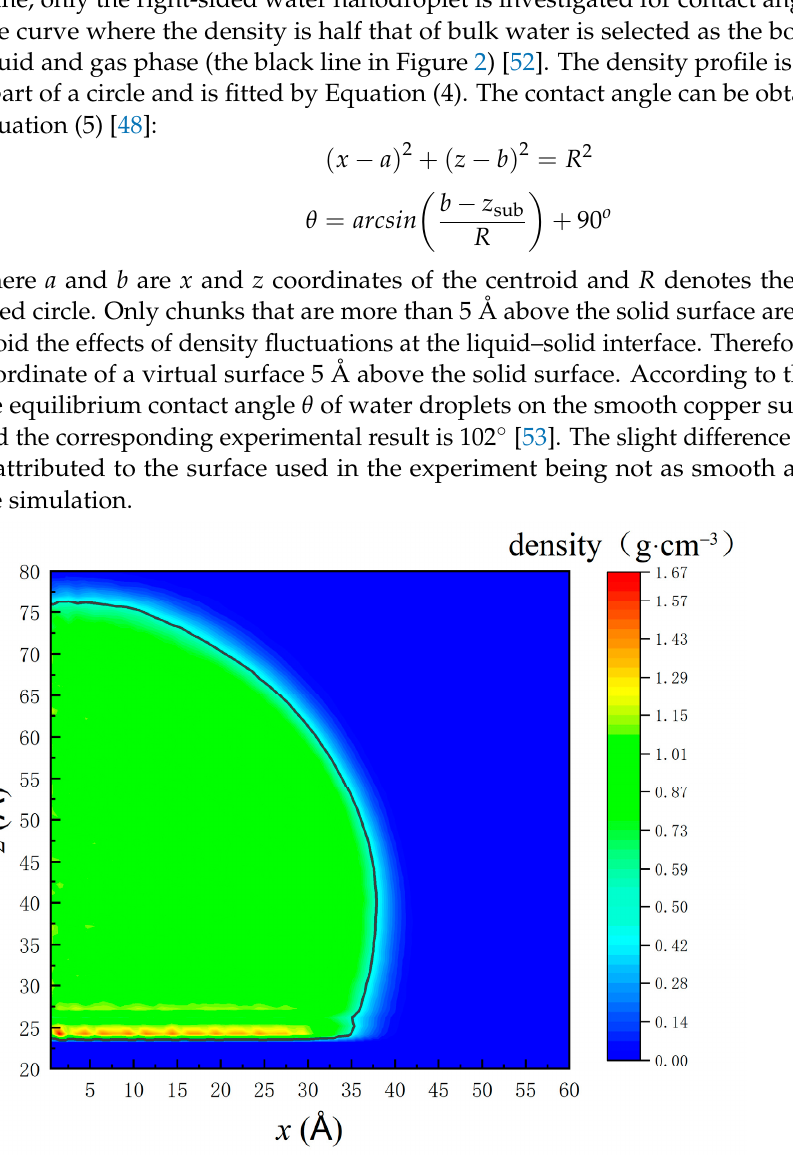
Figure 3. Effects of droplets size on spreading time. It can be seen that although the number of water molecules varies, the R / R 0 of differ- ent nanodroplets are similar to each other, and the maximum relative error is 6.9%. There- fore, the effect of the number of molecules arranged in the droplet can be neglected. Tak- ing the computation accuracy and efficiency into consideration, nanodroplets with R 0 = 35 Å are adopted. 3.2. Effects of Translation Velocity When Water Nanodroplets Impinge on Translation Surfaces Considering the inertia force plays an important role in the impinging process, the Weber number ( We ) is chosen to represent the characteristics of water nanodroplets [54]. The effects of translation velocity of surfaces V s on the dynamical behaviors of water nanodroplets with We = 7.41 are investigated. We is defined as 𝑊𝑒 = 𝜌𝑅𝑉 (cid:3053)(cid:2870) 𝛾 (6) where R is the radius of the droplet, V z represents the velocity of droplets, and the surface tension γ = 72.75 mN/m [52]. The morphological evolution of water nanodroplets is illus- trated in Figure 4. Due to the sufficient simulation period, water nanodroplets can exceed the simulation box boundary, and they re-enter the box from the opposite side because of the periodical boundary conditions. For the sake of clarity, the dimensions of boxes and surfaces in x direction are assumed to be infinite.